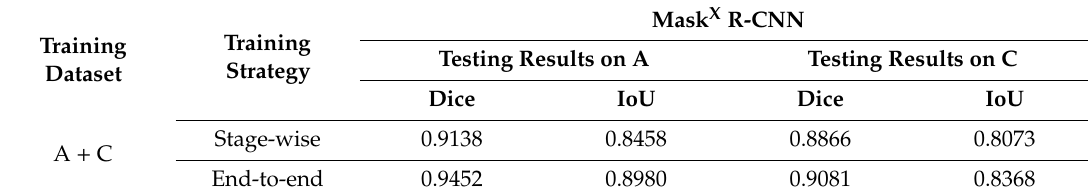
Table 8. Performance comparison between stage-wise training and end-to-end training